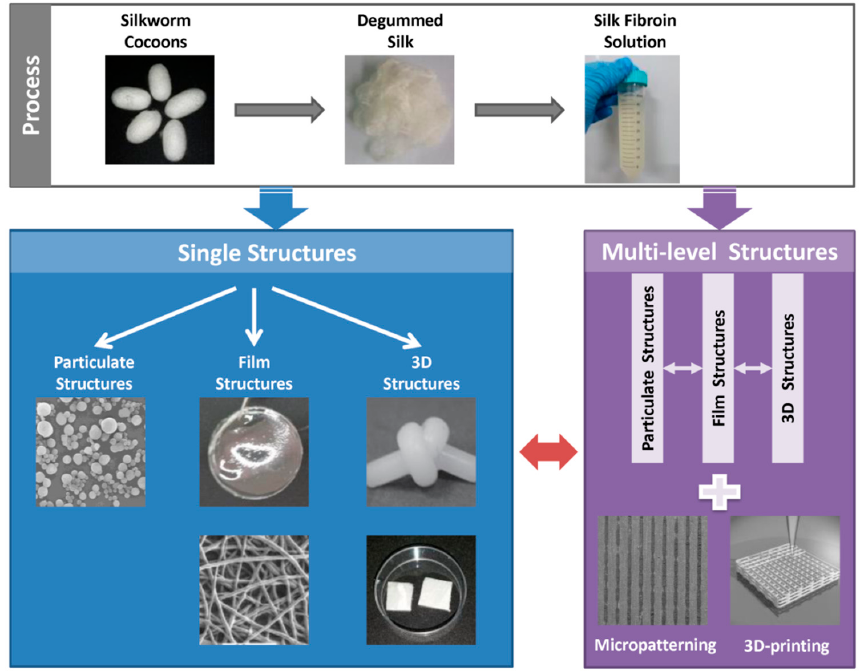
Figure 2. Structural design of SF-based biomaterials from single structures to multi-level structures. Reproduced from [34,35].